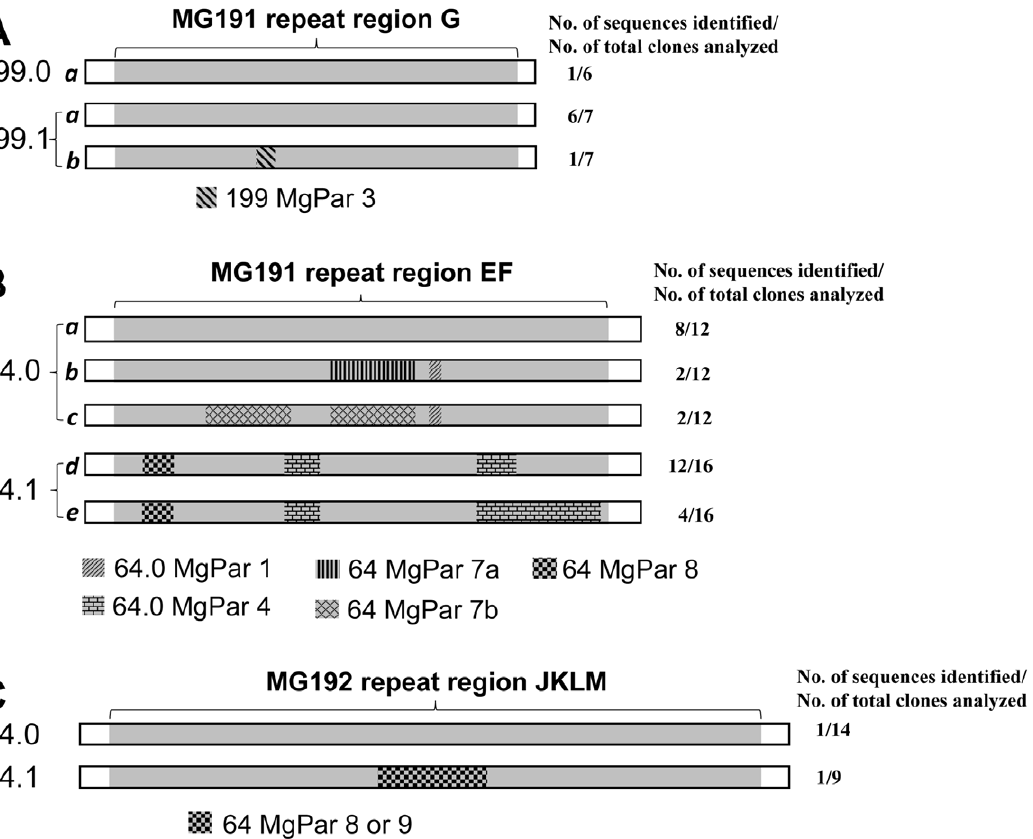
Figure 3. Sequence shifts in MG191 and MG192 repeat regions in two sequential urine specimens from each of two Mycoplasma genitalium –infected patients (199 and 64, Table 1). ( A ) In patient 199, sequence shifts were identified in MG191 repeat region G as shown here as well as MG192 repeat region JKLM as described elsewhere [11]. The sequence change between these two variant sequences in repeat region G ( a and b ) could be explained by homologous recombination with MgPar 3, which was identical between the first- and second-visit specimens. ( B ) Sequence shifts in the MG191 repeat region EF in patient 64. ( C ) Sequence shift in the MG192 repeat region JKLM in patient 64. Except for two single base substitutions in (B) all sequence changes could be explained by homologous recombination with a MgPar sequence found in the first- and/or the second-visit specimen as shown. MgPars 2, 7, 8 and 9 were obtained from both specimens with MgPars 2, 8 and 9 being identical between the first- and second-visit specimens while all remaining MgPars were obtained only from one specimen. Each repeat region along with its upstream and downstream conserved regions was amplified as one fragment and sequenced after subcloning, with the number of plasmid clones analyzed shown on the right of each bar. Sequence changes in each variant and their matching MgPars are indicated by texture. The sequences for the two variants of MG191 repeat region in A , and five variants of MG191 repeat region EF ( a through e ) and 2 variants of MgPar 7 (7a and 7b) in B are available under GenBank accession numbers HQ011255-61, FJ872565 and FJ872566. The remaining accession numbers are listed in Methods.